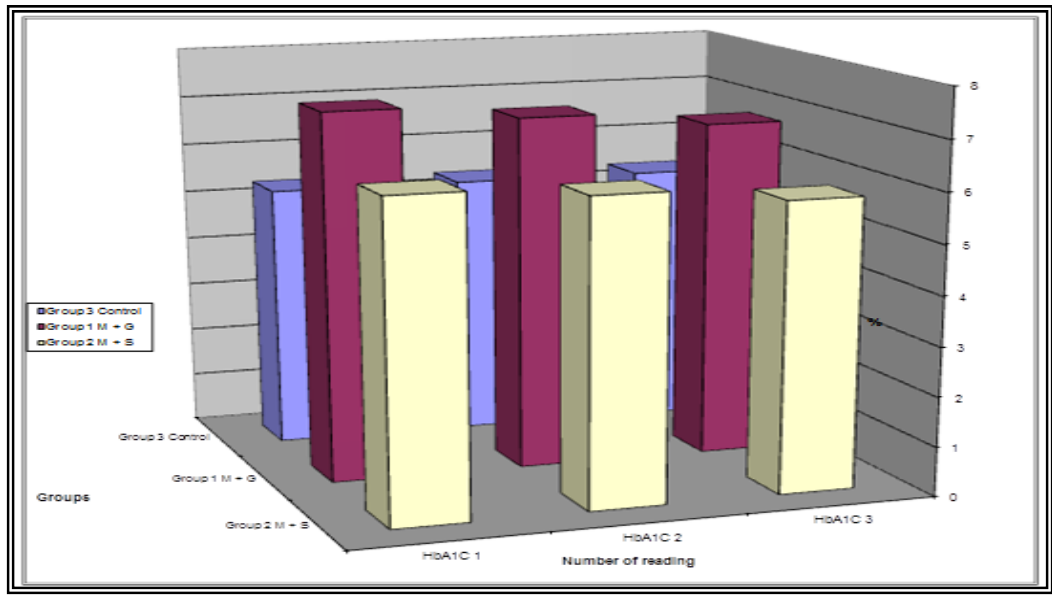
Figure 3:Histogram showing effect of treatment with metformin 500 mg 3 times daily + glibenclamide 5 mg twice daily (group 1) versus metformin 500 mg 3 times daily + sitagliptin 100 mg once daily (group 2) on HbA1c (%) in patients with T2DM and control normal healthy individuals (group 3 ) after 1,3 and 6 months of treatment .( n = 34 individuals for each group )